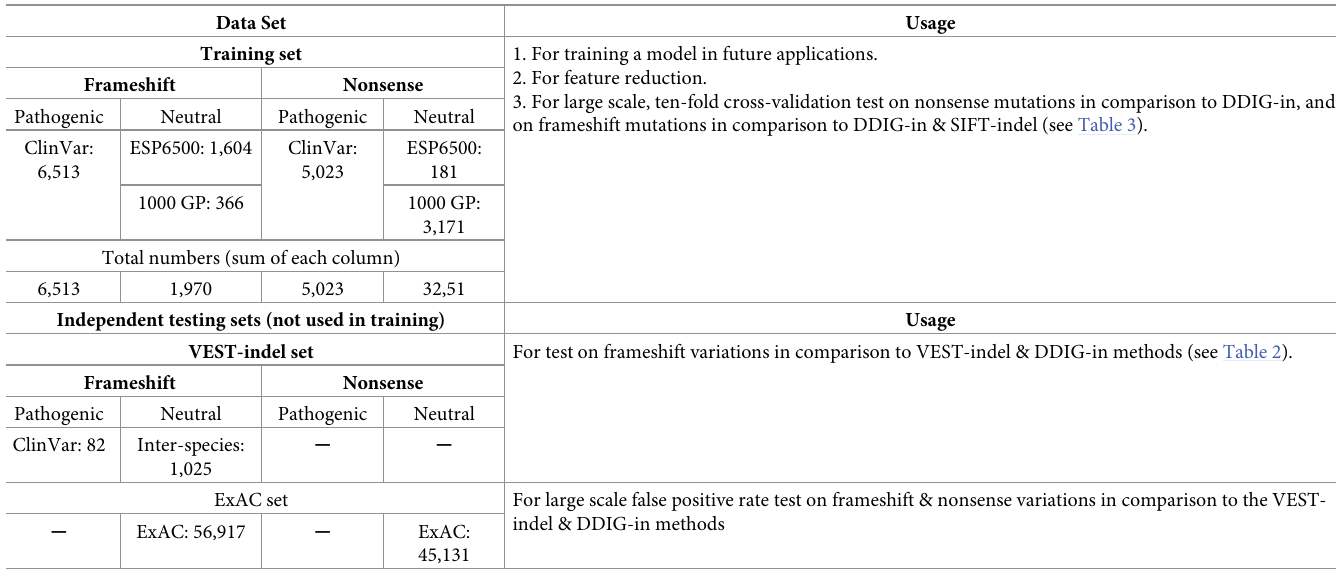
Table 1. Summary of variations in the ENTPRISE-X training and testing data sets. Data